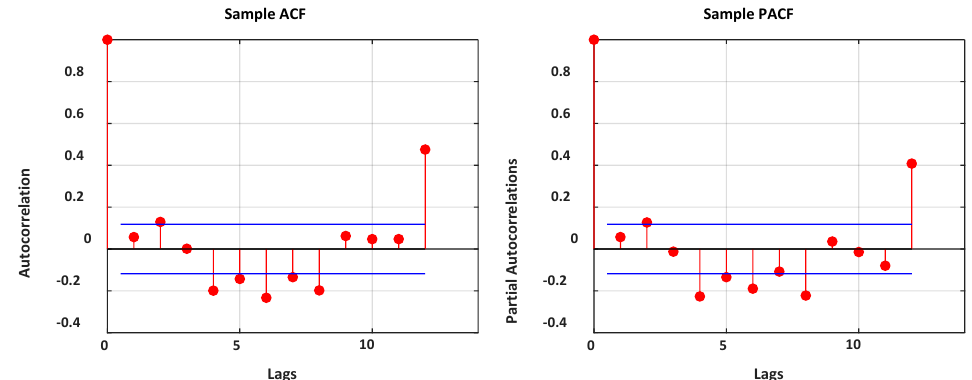
Figure 5. Sample autocorrelation function (ACF) and partial autocorrelation function (PACF) plot of squared residuals.